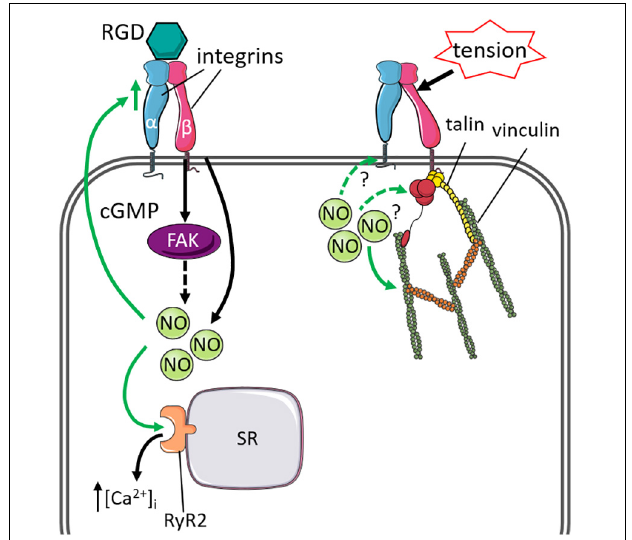
FIGURE 1 | Cytoskeletal proteins linked to integrin that influence or are influenced by nitric oxide signaling and mechanical stimuli. Left: Stimulation of integrins by ligands containing the Arg-Gly-Asp motif (RGD) increased nitric oxide (NO)-mediated intracellular Ca 2 + [(Ca 2 + ) i ] release from the sarcoplasmic reticulum (SR), via activation of ryanodine receptor 2 (RyR2). The stimulatory effects of NO can also regulate integrin expression via cGMP-signaling. Solid green lines indicate effect by NO. Right: Integrins form a complex with talin and vinculin to stabilize the actin-cytoskeleton under mechanical stress. The effect of cardiac NO signaling on the integrin-talin-vinculin complex remains to be investigated (green dashed